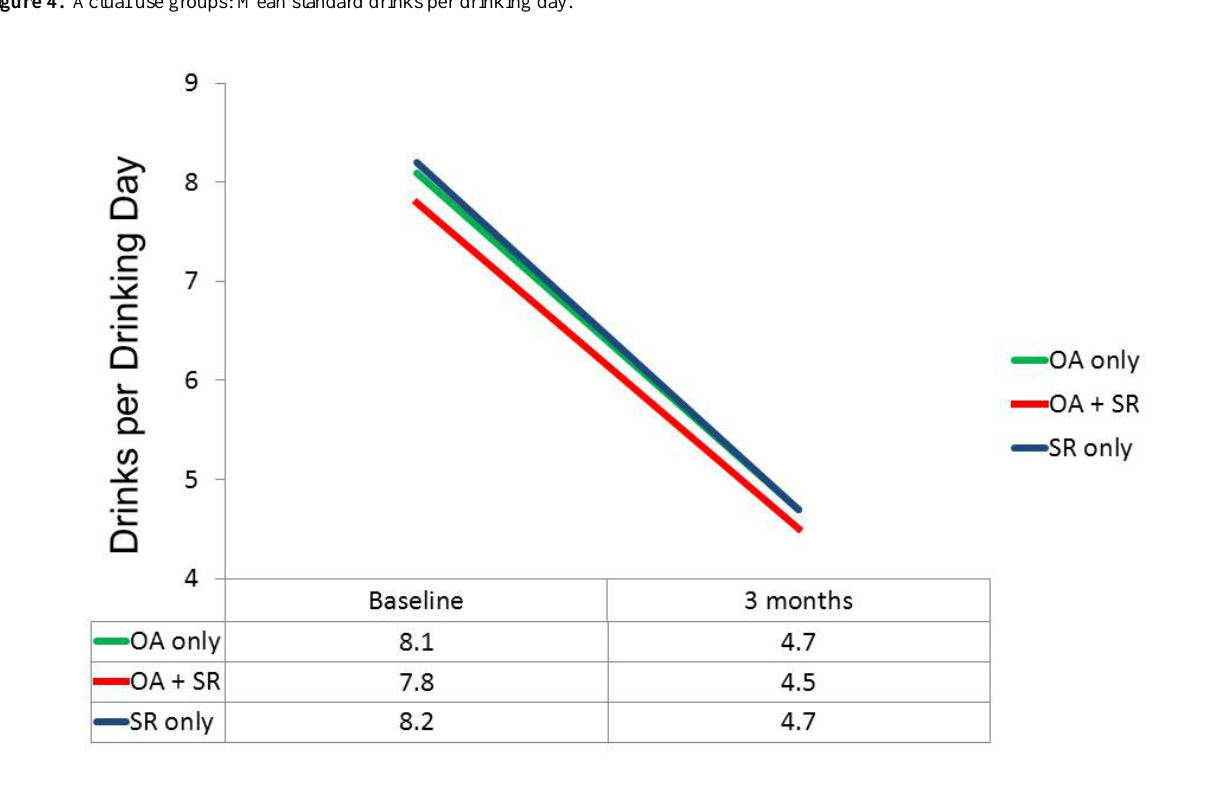
Figure 4. Actual use groups: Mean standard drinks per drinking